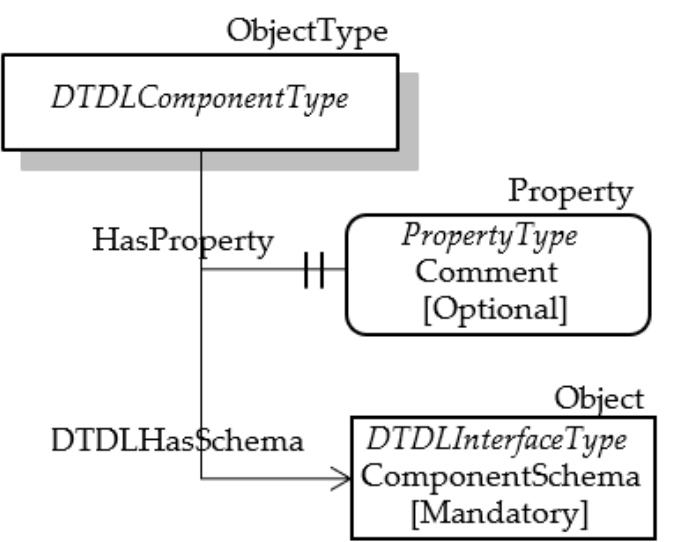
Figure 10. OPC UA